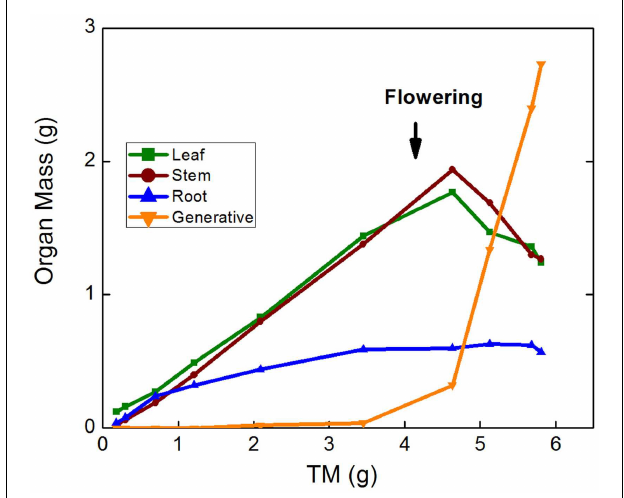
FIGURE 3 | Leaf, stem, root, and reproductive mass of Pisum sativum plotted against total plant mass (TM). Plants were grown hydroponically in a growth room from the seedling to the generative stage (P.W. Wolswinkel andT. L. Pons, pers.